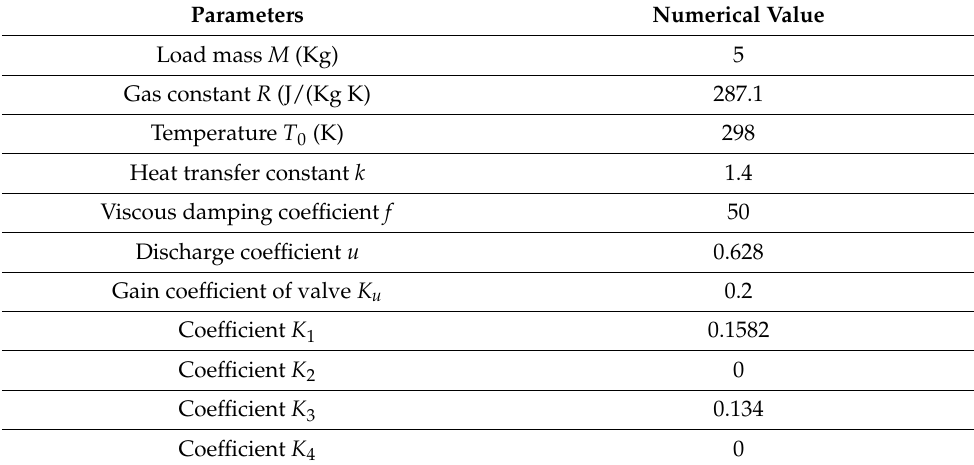
Table 1. Relevant parameters of the pneumatic servo